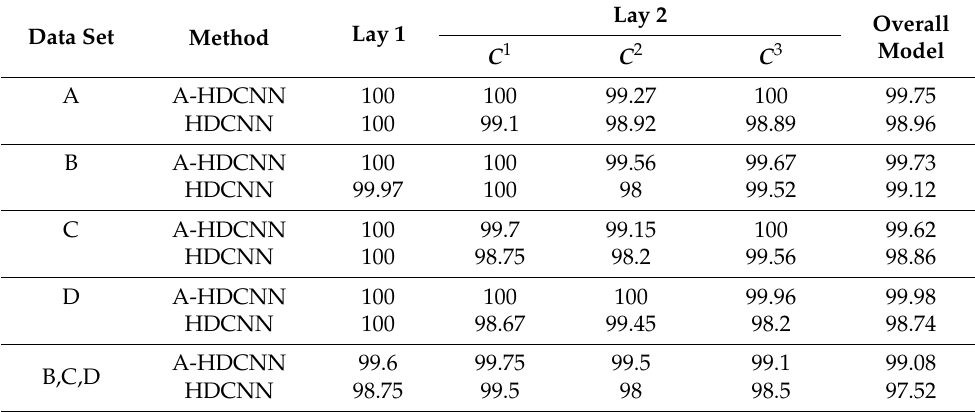
Table 5. Comparison of model diagnosis accuracy between A-HDCNN and HDCNN under different load